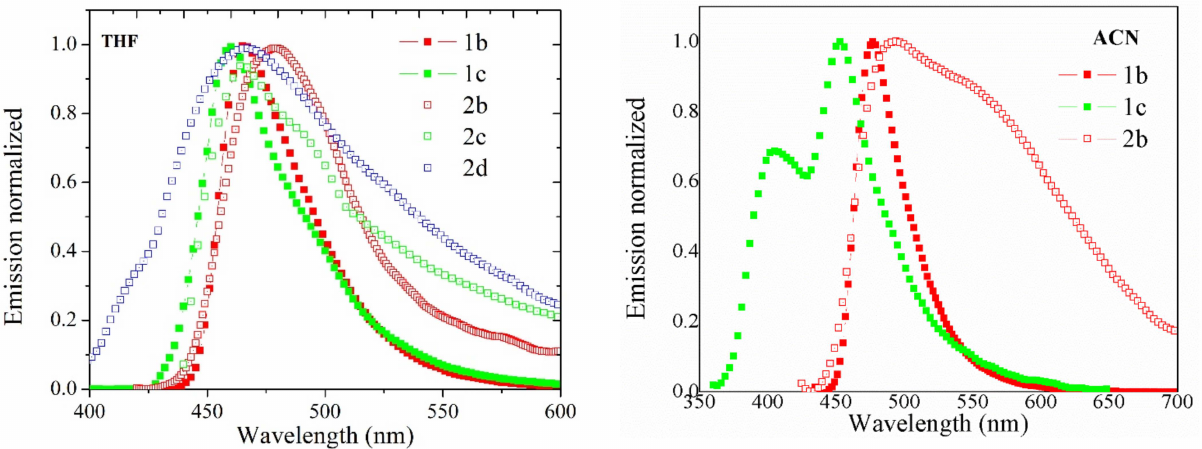
Figure 2. Fluorescence spectra of compounds 1b , c , 2b – d in THF and 1b , c , 2b in acetonitrile solutions ( c = 1 × 10 − 4 M, at 25 ◦ C). λ ex (Em) = λ max (Abs). Compound 2c , d do not have